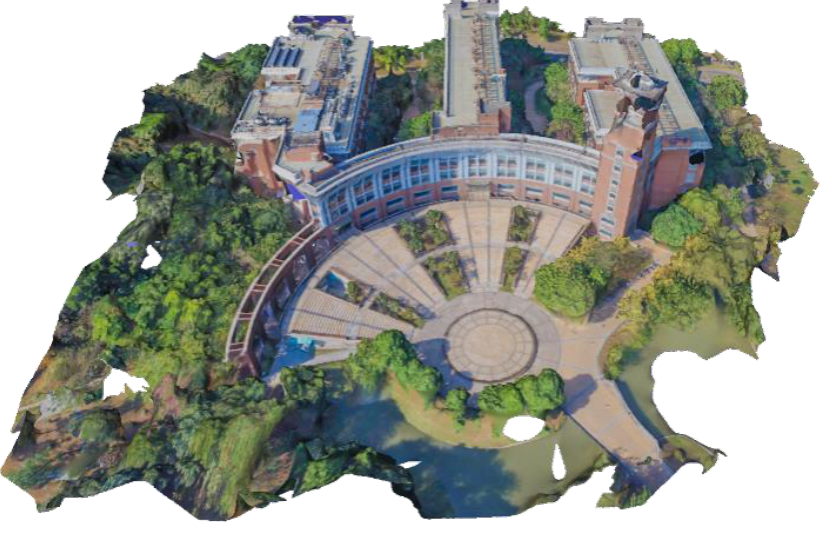
Figure 12. Reconstructed result of the target area.